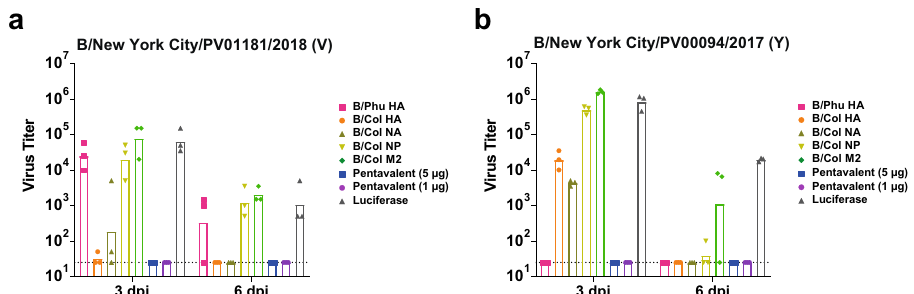
Fig. 7 | A single immunization with IBV pentavalent mRNA-LNP vaccine pre- vents virus replication. Mice were I.D. vaccinated once with 5 μ g of monovalent mRNA-LNPs or with 5 μ g/antigen or 1 μ g/antigen of the pentavalent mRNA-LNP formulation. Control animals received 5 μ g of luciferase mRNA-LNP. Virus titers in the lung homogenate of mRNA-LNP-vaccinated mice at 3 and 6dpi following I.N. challengewith1mLD 50 ofB/NewYorkCity/PV01181/2018(V)( n =3mice/group)( a ).